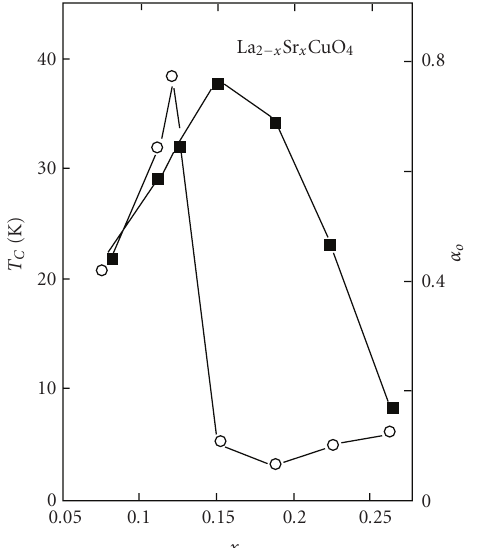
Figure 5: From [26], experimental results of T C ( (cid:2) ) and α o ( (cid:8) ) as a function of doping concentration for La 2 − x Sr x CuO 4 (the data where taken from [24]).